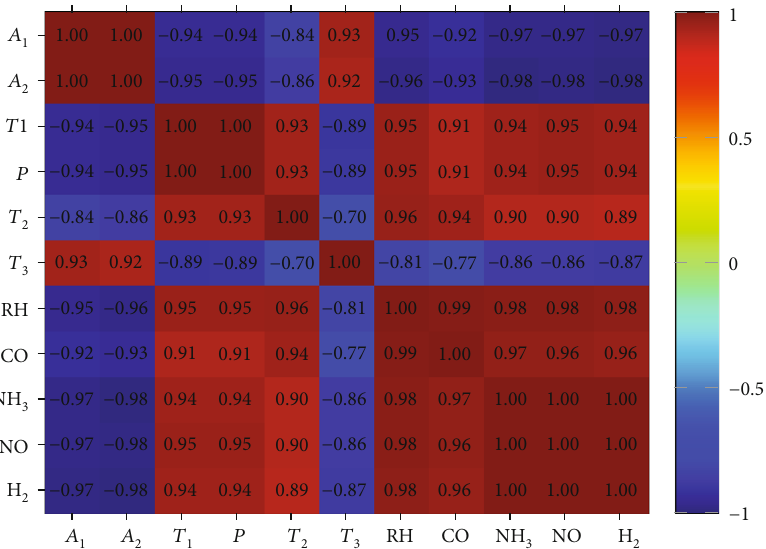
Figure 18: Correlation matrix between dependent variables DV and the independent variable IV A